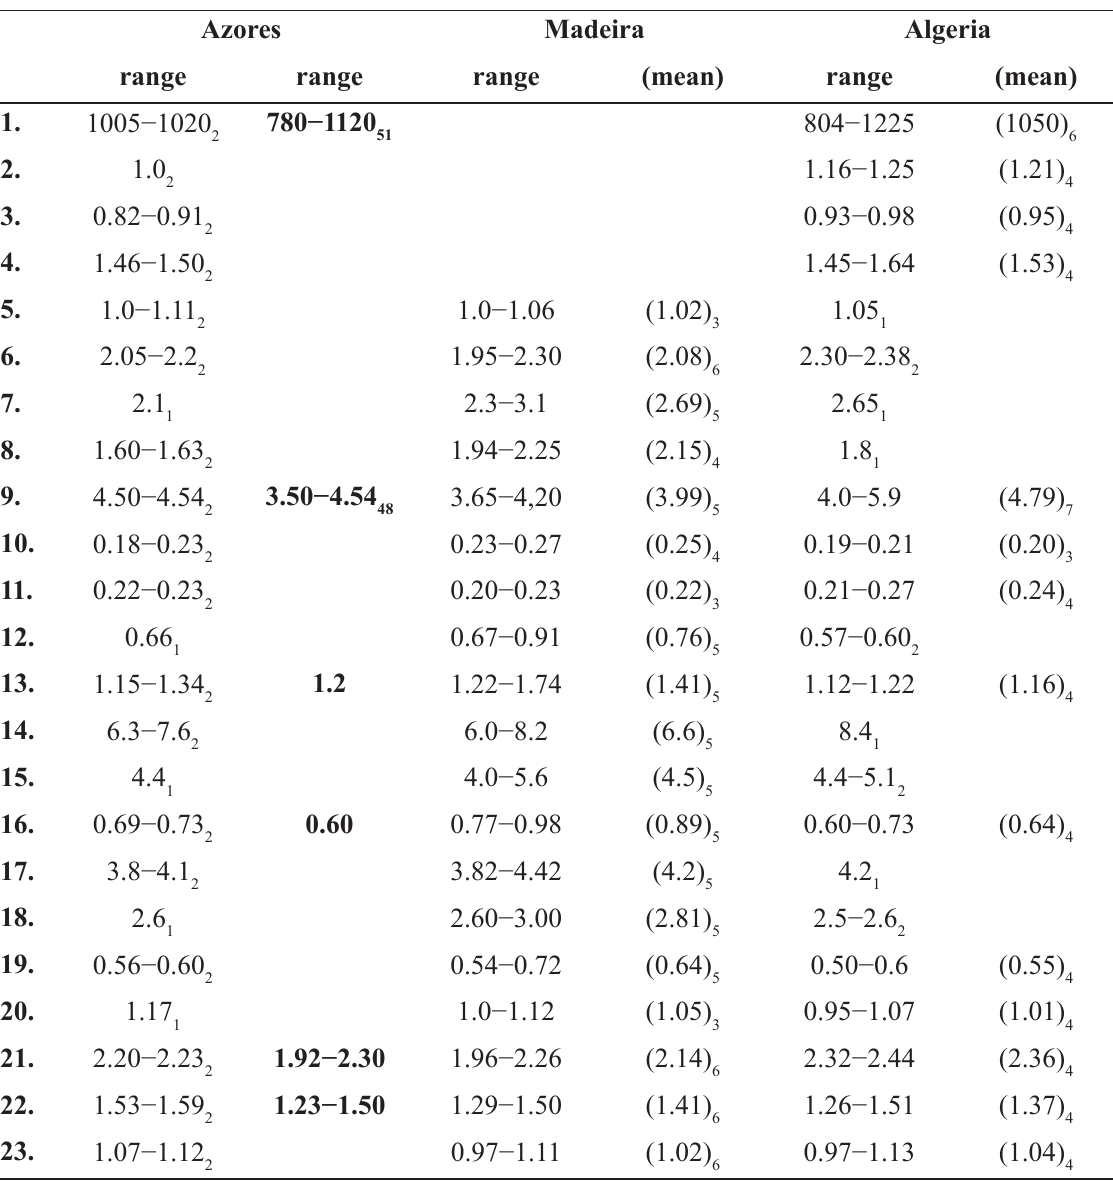
Table 1. Geographic variation of the female morphometric characters in Eucyclops azorensis Defaye & Dussart, 1991. Data in bold are from the original description of the species (Defaye & Dussart 1991). Numbers in subscript refer to the numbers of specimens